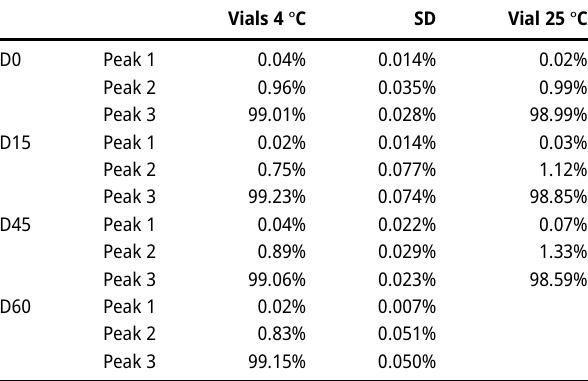
Table  : Peak percentages demonstrated by SEC for vials containing  mg/mL and stored at  ° C (n=  ) and  ° C (n=  ).